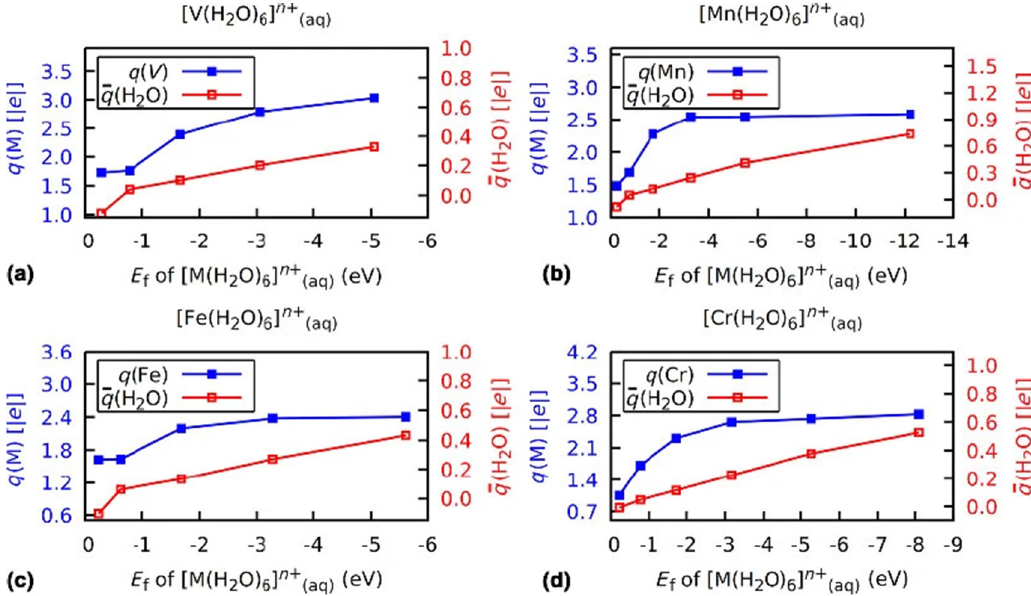
Figure 6. Bader charges on the metal center q (M) (blue, filled squares) and average Bader charge on the water ligands q (H 2 O) (red, empty squares) in [ M (H 2 O) 6 ] n + complexes with M = V ( a ), Mn ( b ), Fe ( c ), and Cr ( d ) versus the formation energy E f of the corresponding complex. The FOS of the metal center is increasing from left to right (with increasing formation energy) and spans from +I (all cases) to +V (V and Fe), +VI (Cr), and +VII (Mn). These results were obtained with unrestricted DFT calculations using the PBE0 functional and the cc-pVTZ basis set, and a polarizable continuum model. Reprinted with permission from Springer Nature Customer Service Centre GmbH: Springer Nature [23], Copyright 2018.